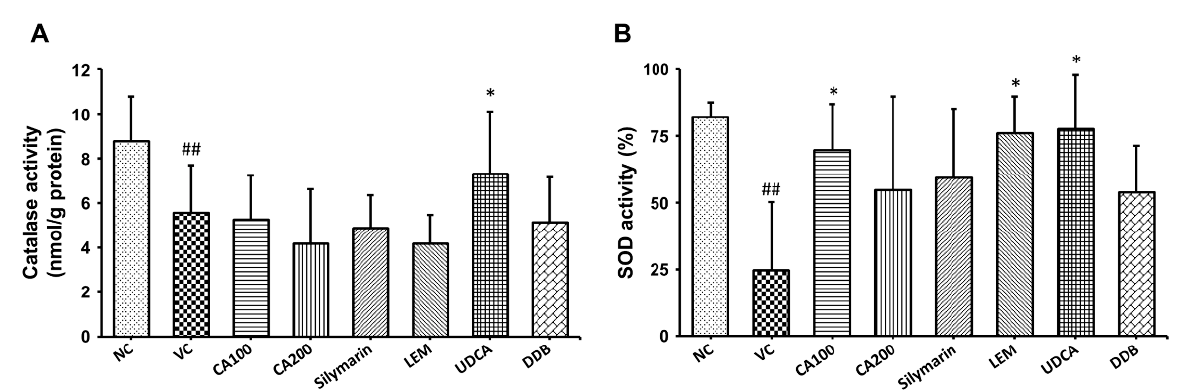
Figure 4. Effects of CA-HE50 on CAT and SOD activities in LPS/D-Gal-induced ALF animal model. The activity changes of representative antioxidant enzymes ( A ) CAT and ( B ) SOD in liver tissue were investigated. NC, normal control; VC, vehicle control; CA100, 100 mg/kg CA-HE50; CA200, 200 mg/kg CA-HE50; Silymarin, 100 mg/kg silymarin; LEM, 200 mg/kg LEM; UDCA, 25 mg/kg UDCA; DDB, 200 mg/kg DDB. Data are represented as mean ± SD ( ## p < 0.01 vs. normal control; * p < 0.05 vs. vehicle control).